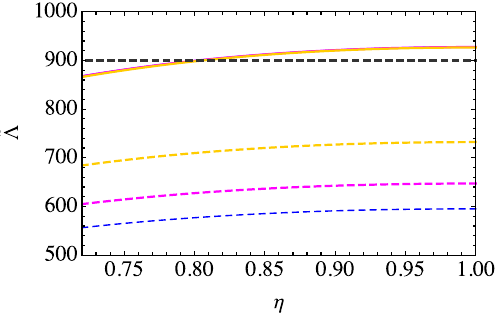
Fig. 4 Combined tidal deformability ˜ (cid:2) as a function of mass ratio η for the case of GW170817. The black-dashed line stands for ˜ (cid:2) = 900